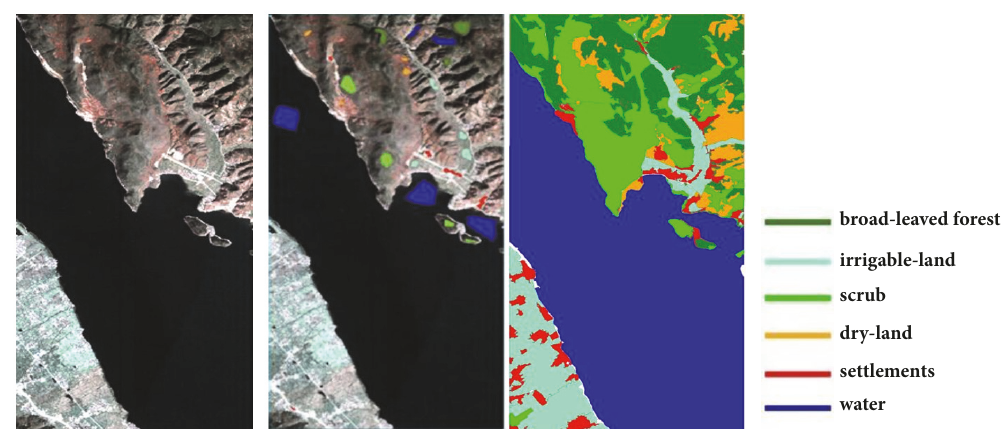
Figure 3: The synthesis true color image (bands 29, 20, and 18) and the overlaid image of training sets of Hyperion data and the ground truth